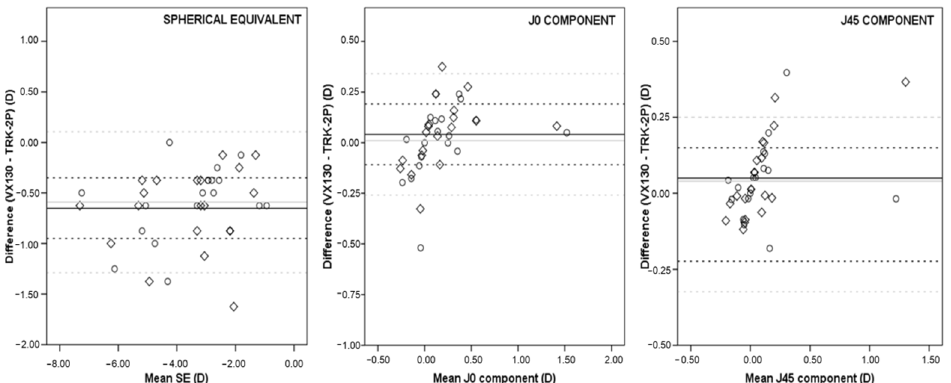
Figure 1. Differences in spherical equivalent ( left ), J 0 component ( center ), and J 45 component ( right ) between Visionix 130 system (VX130) and TRK-2P autorefractometer (TRK-2P) in myopia group without cycloplegia (rhombus; mean bias represented by a solid black line and the 95% limits of agreement by dashed black lines) and with cycloplegia (circle; mean bias represented by a solid grey line and the 95% limits of agreement by dashed grey lines).